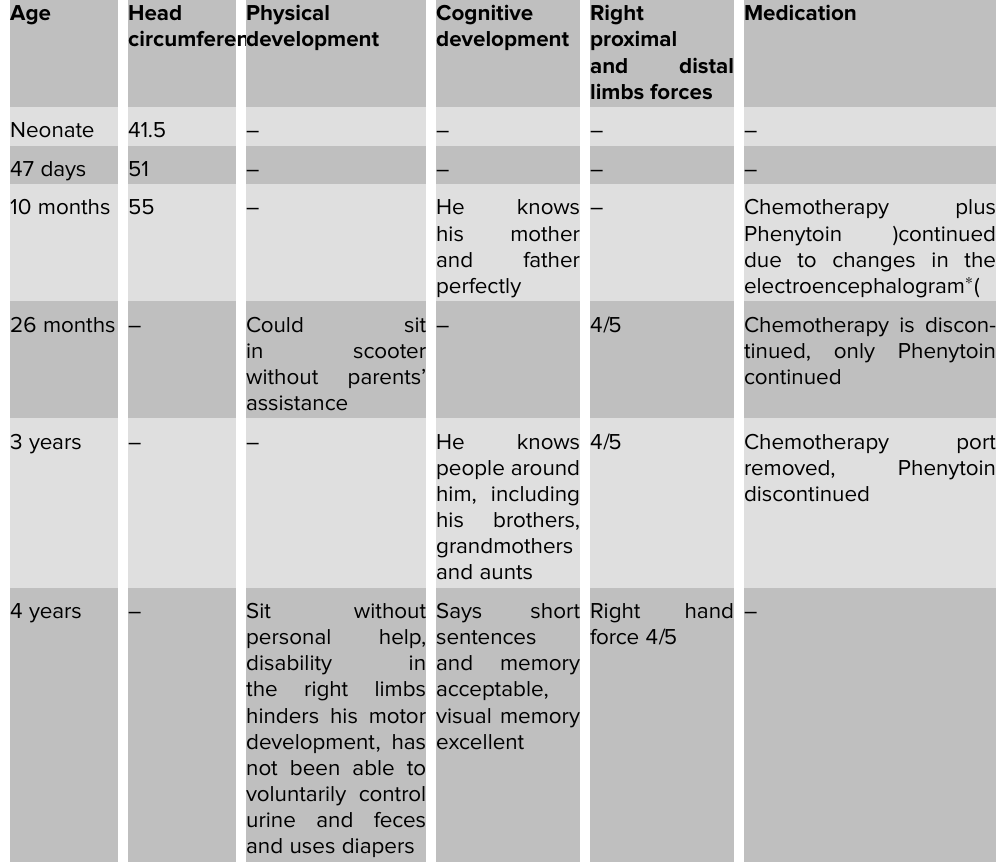
*Although Levetiracetam is the preferred medication for postoperative prophylaxis in patients with brain tumors, Phenytoin was recommended for him four years ago due to its scarcity and high cost in